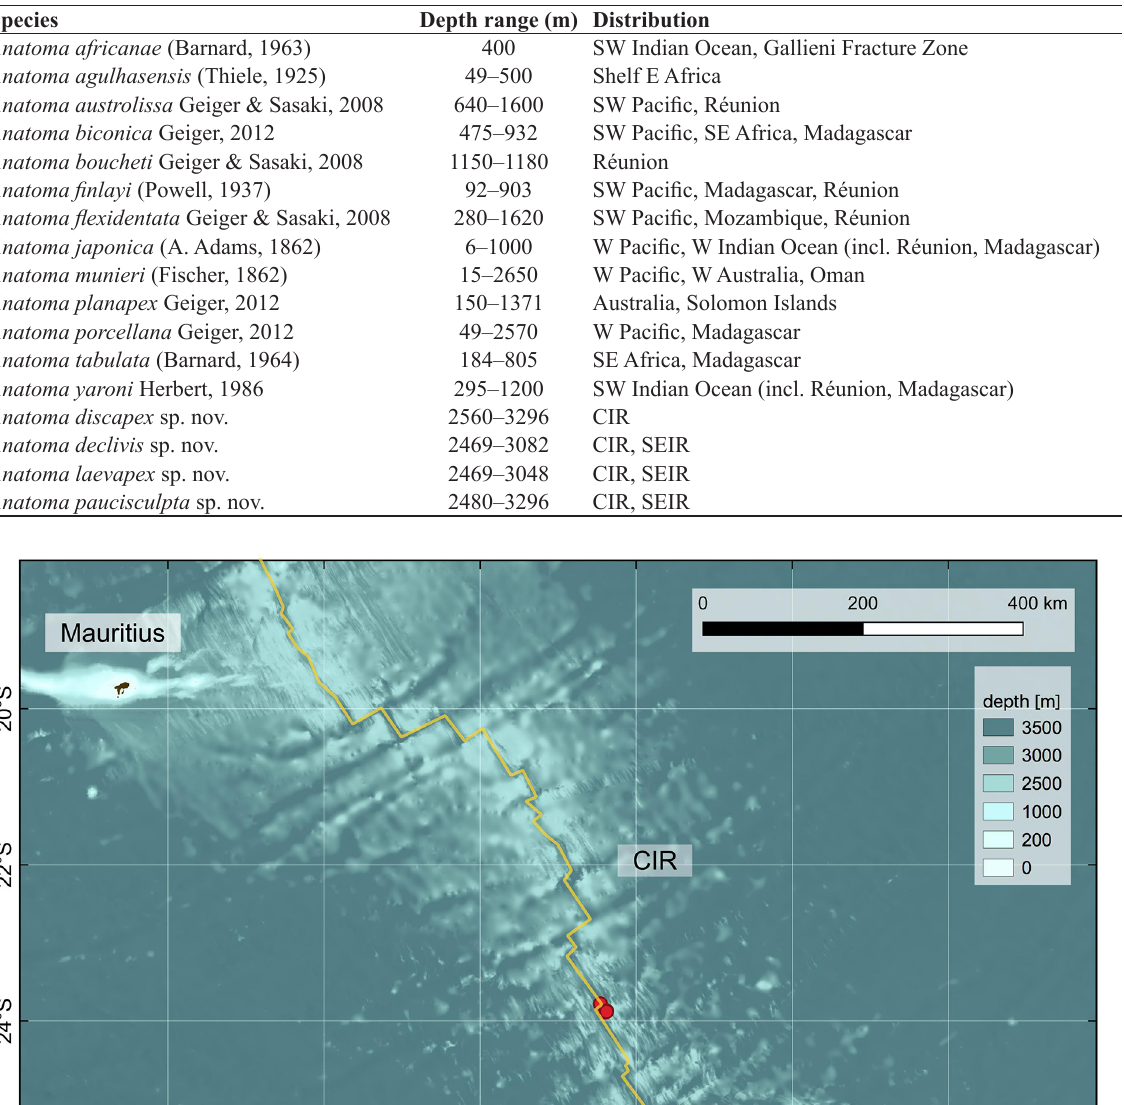
Table 1. Anatomidae McLean, 1989 from the Indian Ocean as given by Geiger (2012). The last four species are described as new in this study.